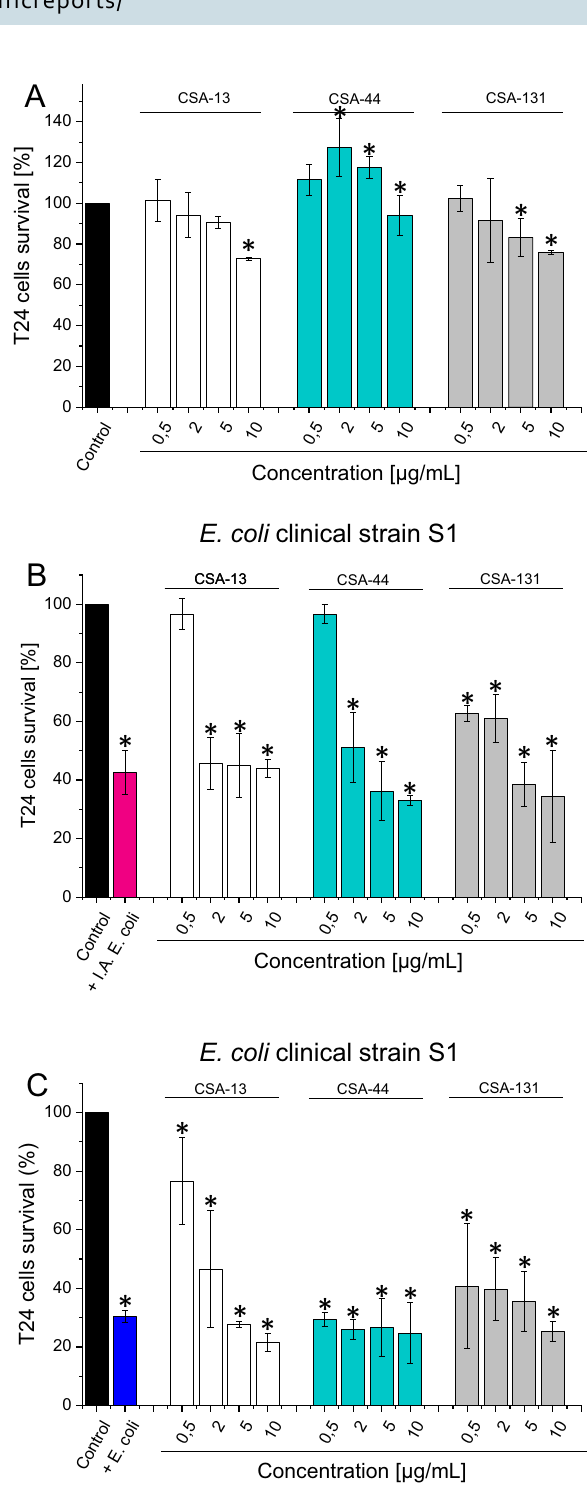
Figure 2. Survival of human urinary bladder cancer cells T24 (HTB-4™) upon incubation with CSA-13, CSA-44 and CSA-131 at doses of 0–10 µg/mL for 24 h ( A ). Cytotoxic effect of cationic lipids against T24 cell line after cells incubation with both heat-inactivated ( B ) and life ( C ) E. coli